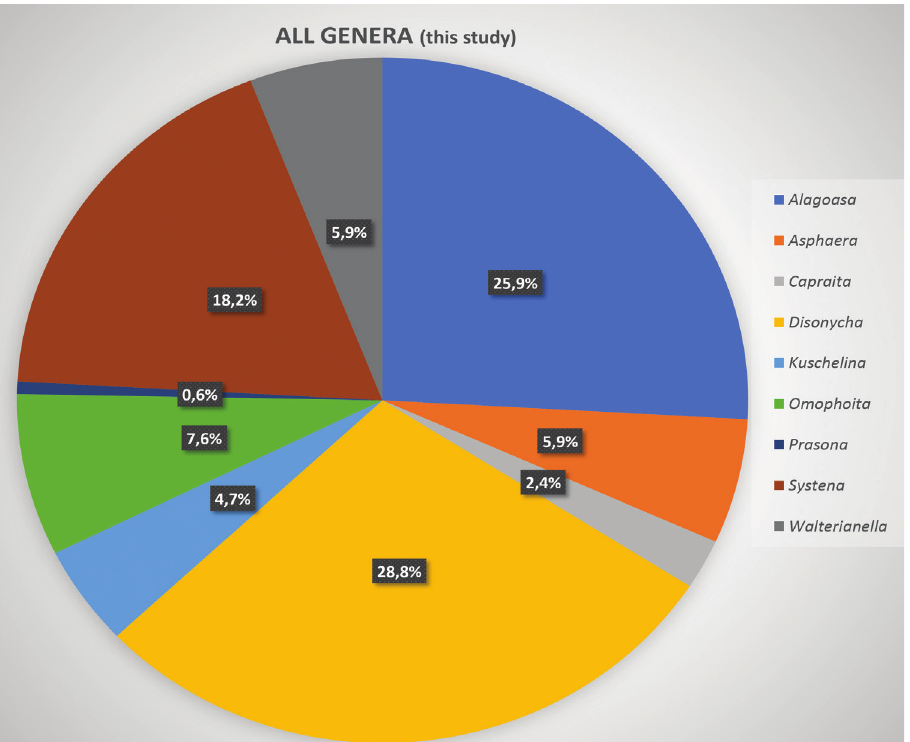
Figure 11. Summary of all genera with species